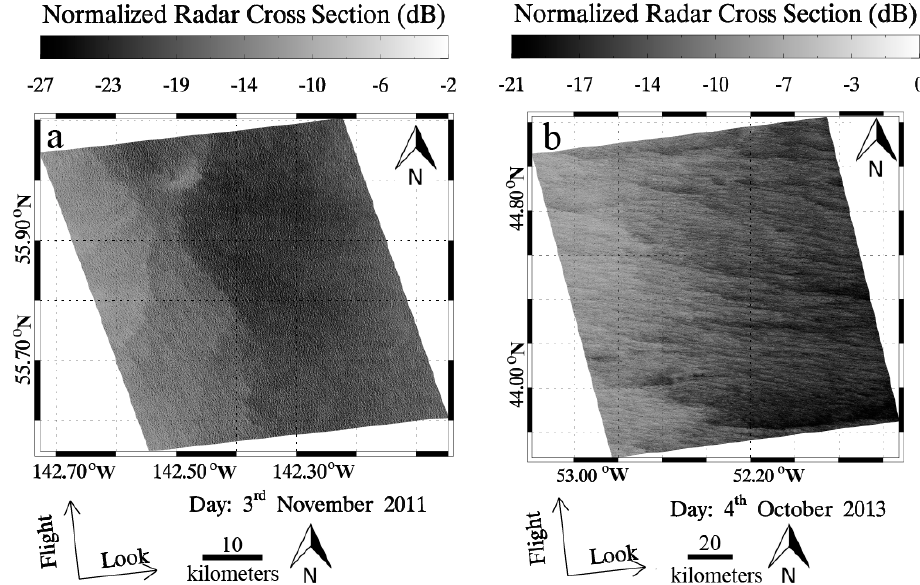
Figure 1. ( a ) A HH-polarization StripMap mode TerraSAR(TS-X) image acquired in Gulf of Alaska at 03:05 UTC on 3 November 2011; and ( b ) a VV-polarization ScanSAR mode TanDEM-X (TD-X) image acquired to the Southeast of Newfoundland at 21:17 UTC on 4 October 2013.